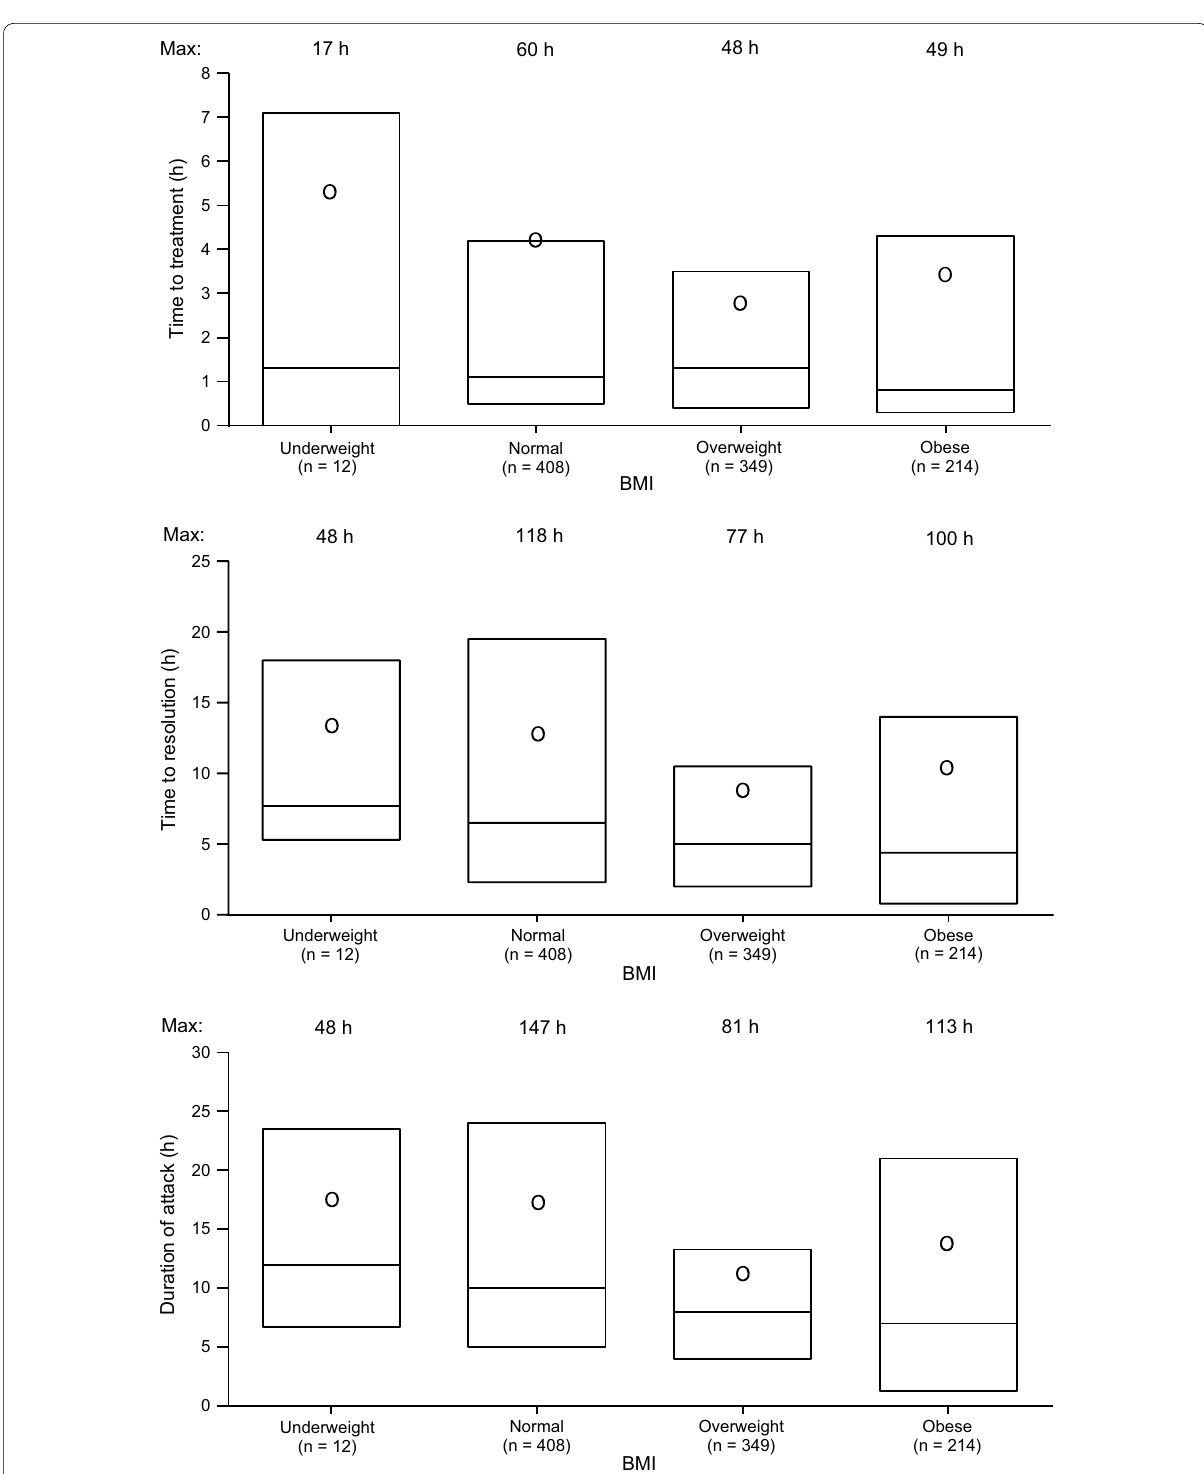
Fig. 3 Outcomes of attacks treated with icatibant by body mass index (BMI). Analysis included attacks with data for all three outcomes. Boxes depict 25th percentile, median, and 75th percentile. Mean indicated with “ ○ ”. P values refer to comparisons versus normal BMI: time to treatment, P 0.007 versus overweight and P 0.385 versus obese; duration of attack, P < 0.001 versus overweight and P = = tion, P < 0.001 versus overweight and P 0.021 versus obese. Results excluding data from the two reinjection outliers are presented in Additional = file 1: Figure S3. Max maximum value. n number of attacks. Time (h) is base-10 = =